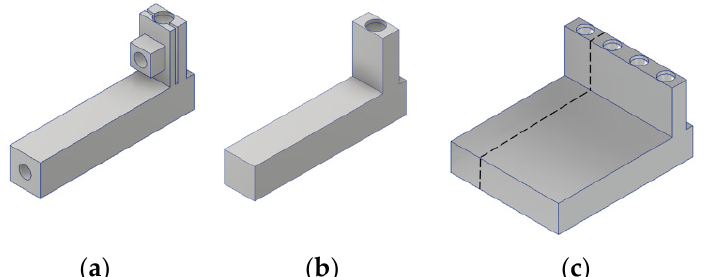
Figure 35. An example showing the idea of part shape simplification by extruded geometry, from ( a ) to ( b ) and manufacturing by applying a multi-part intermediate object ( c ).